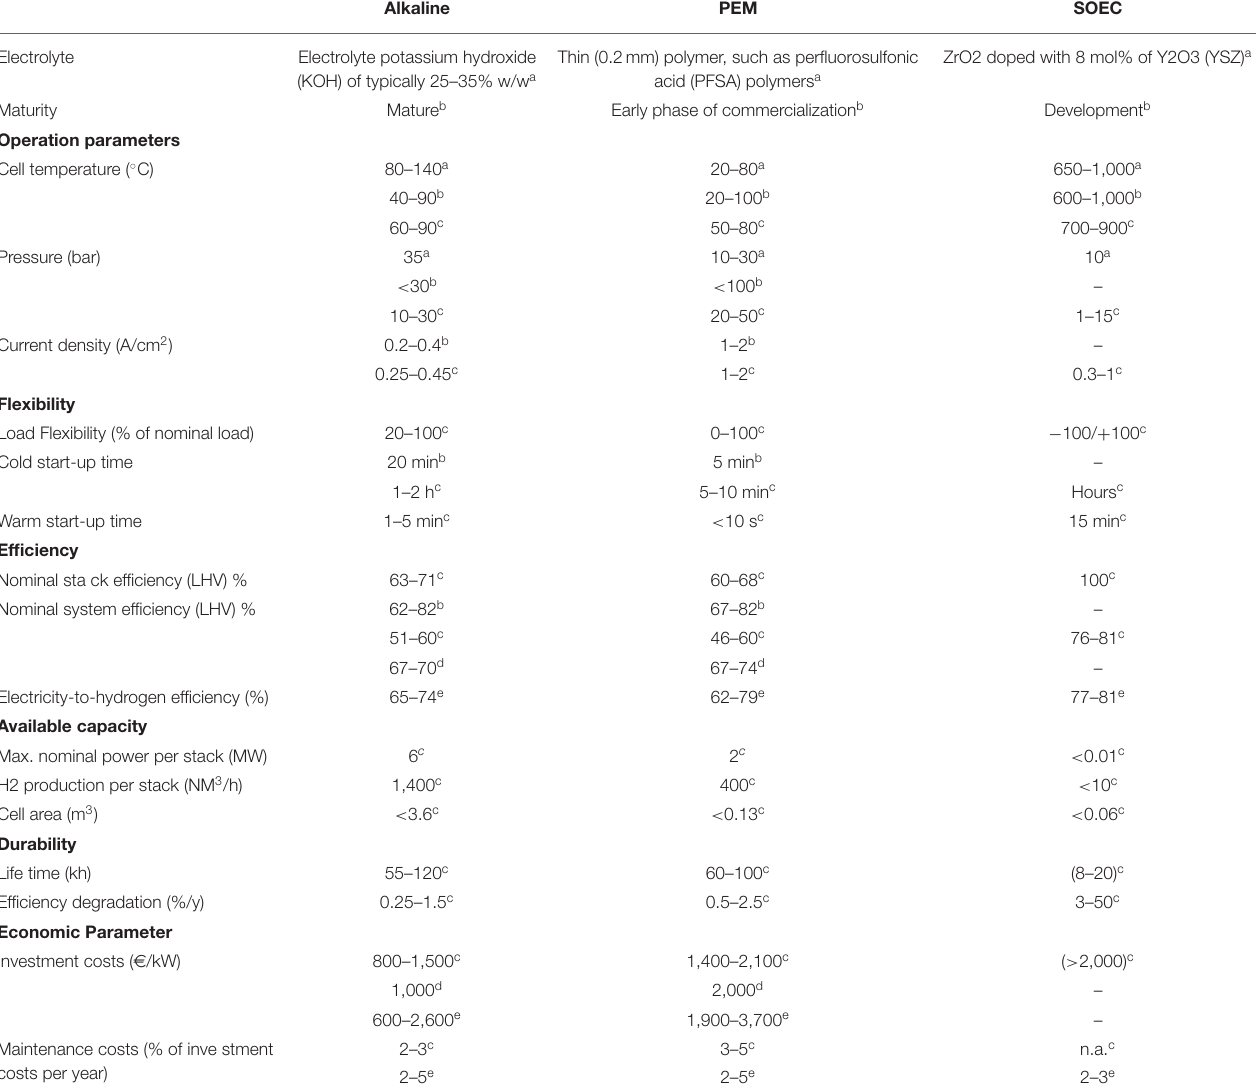
TABLE 3 | Parameters of water electrolysis technologies: alkaline, PEM and SOEC—based on a Balcombe et al. (2018), b Ghaib and Ben-Fares (2018), c Buttler and Spliethoff (2018), d Schiebahn et al. (2015), e Brynolf et al. (2018). Alkaline SOEC